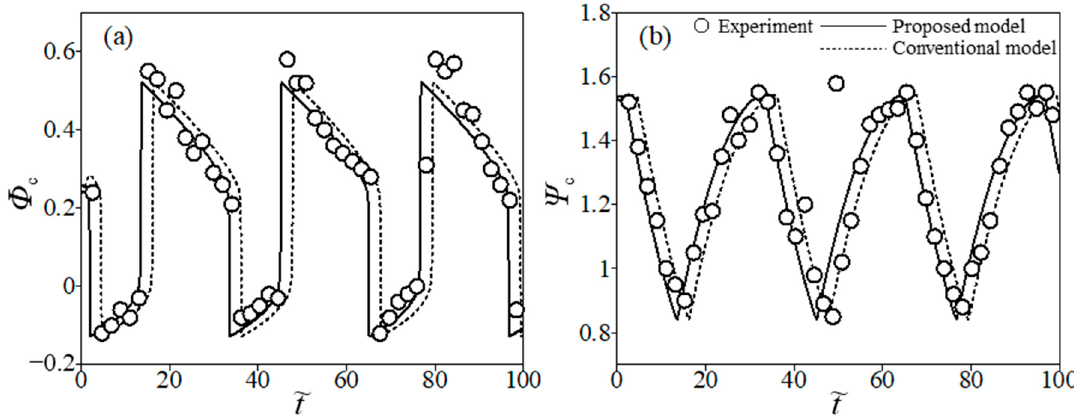
Figure 11. Comparison of simulation results: ( a ) non-dimensional mass flow rate and ( b ) non-dimensional pressure rise.